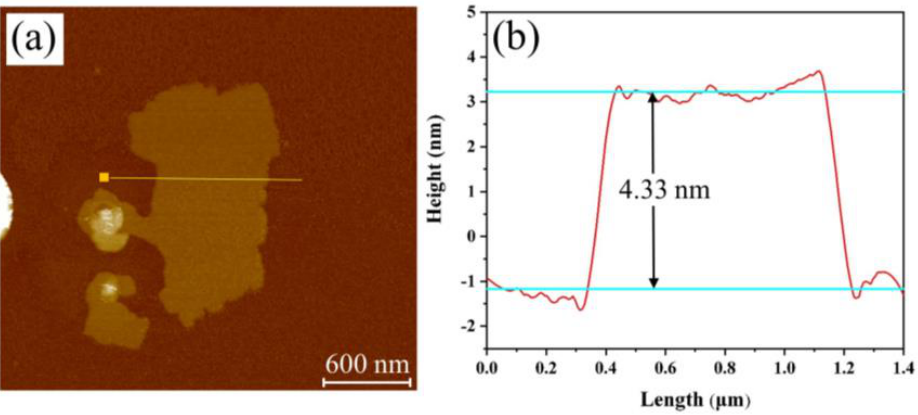
Figure 2. ( a ) Typical AFM image; and ( b ) the corresponding height profile of GO sheet. The SEM images of the produced MREs are shown in Figure 3. It can be seen that MRE-0 has a uniform distribution of CIPs without obvious aggregation (Figure 3a). GO aggregations can be occasionally observed in MRE-1 and MRE-3 (Figure 3b,c). There are also some GO sheets with the size over 10 µ m and the micro-fissures caused by pulling out of GO sheets present in the fracture surfaces, as illustrated in Figure 3b,c. However, GO sheets with smaller size can rarely be observed in the fractured surfaces, indicating they are deeply embedded in the matrix. In the fracture surface of MRE-5, however, the GO aggregations and micro-fissures caused by pulling out of GO sheets become more serious. These results indicate that the restack of the exfoliated GO sheets happens in the GO/PDMS pre-polymer solution during the stirring and THF evaporation processes, and Figure 3e shows a magnified view of the fractured surface of MRE-5. It can be observed that some small CIPs are absorbed on the GO surfaces or aggregated near the GO sheets, which may be caused by the strong adsorption between GO sheets and CIPs. Zhang et al. [41] also found that the micron-sized GO plates can adhere on the surface of CIPs and fulfill the free interspace among CIPs in the CIPs/GO mixture-based MRFs, thus enhancing the viscosity and improving the sedimentation problem of MRFs. The increased viscosity of the GO/PDMS emulsion with the increase of GO content (see Figure S1) was also found in this work. However, this makes uniformly distributing CIPs during the fabrication process